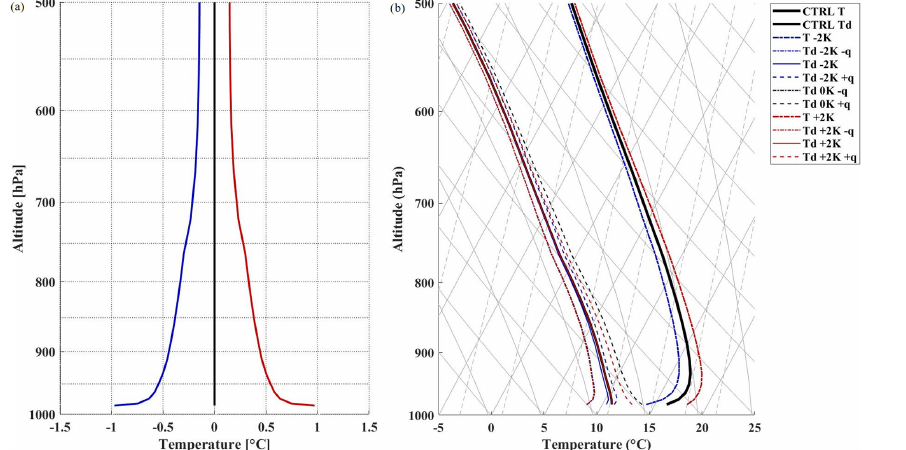
Figure 4. Temperature modification factor derived using a simple linear regression model and extracting the coefficient of determination for each atmospheric layer (a) . Profiles of temperature ( T ) and dew-point temperature ( T d ) after modification (b) . Red indicates warmer temperature and blue cooler temperatures, and unchanged temperature is denoted in black. Dash-dotted lines indicate a reduction in moisture, solid lines unchanged moisture and dashed lines an increase in